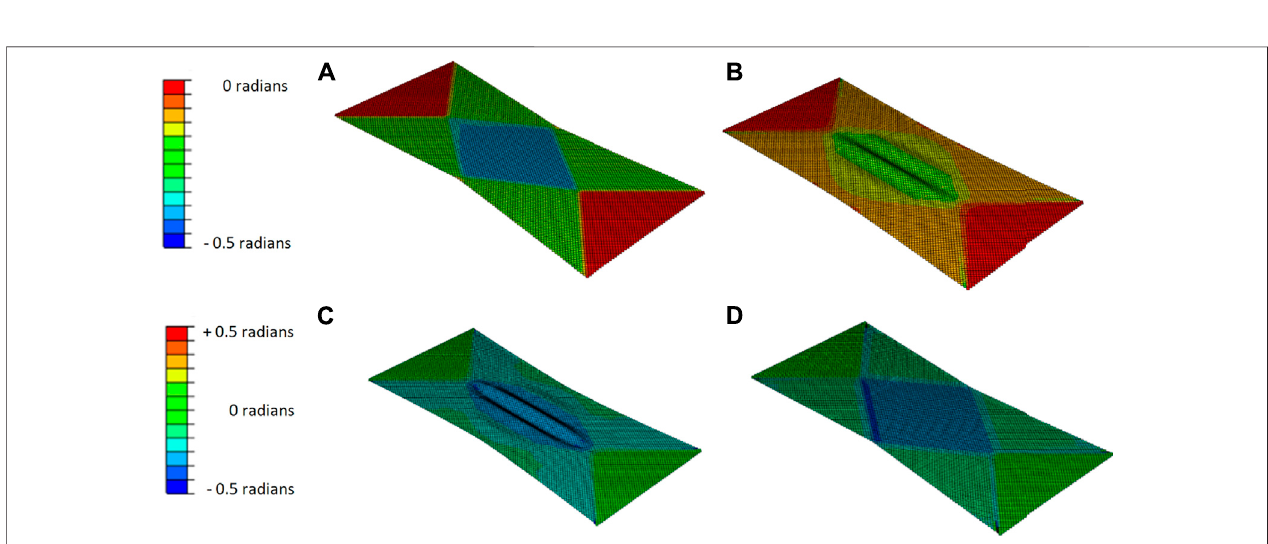
FIGURE6| Comparisonofthedeformationpatternat20 ° shearangleinthepureshearzonefor (A) dryfabricand (B) 50%coverage)alsocomparisonat16 ° for (C) 50% coverage (D) central stripe.